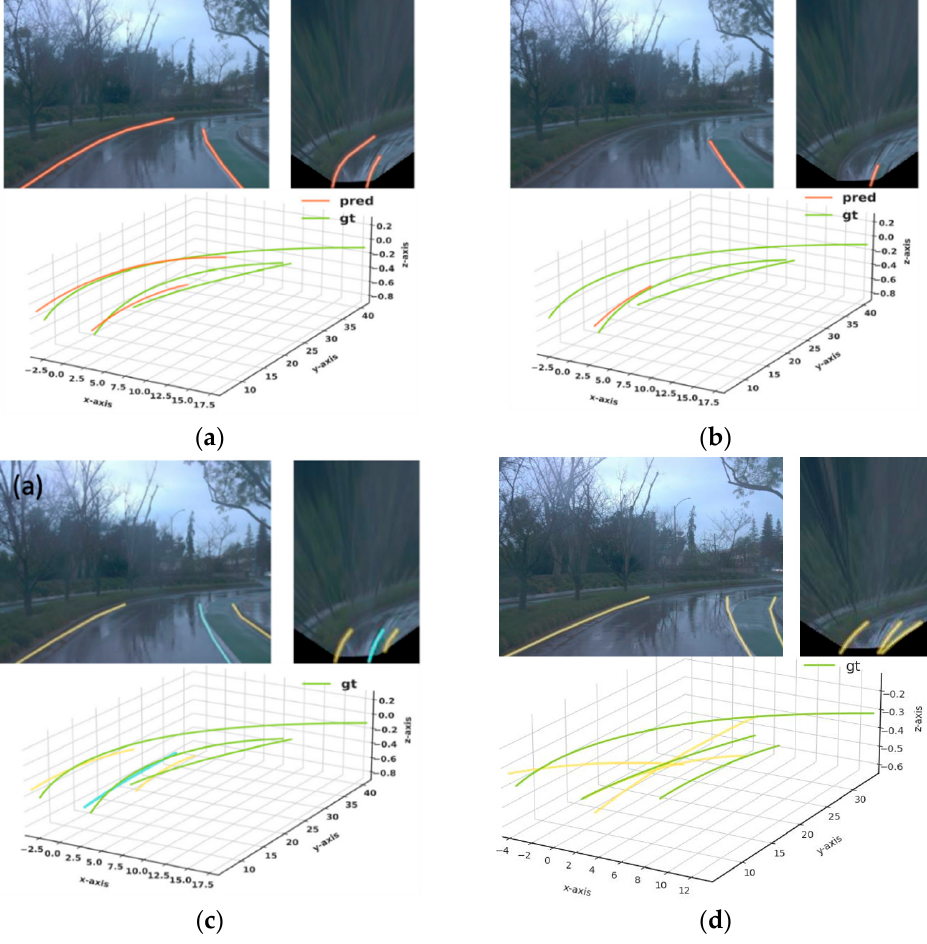
Figure 9. Qualitative comparison between ( a ) 3D-LaneNet [34], ( b ) Gen-LaneNet [35], ( c ) PersFormer [13], and ( d ) proposed method on curve case.